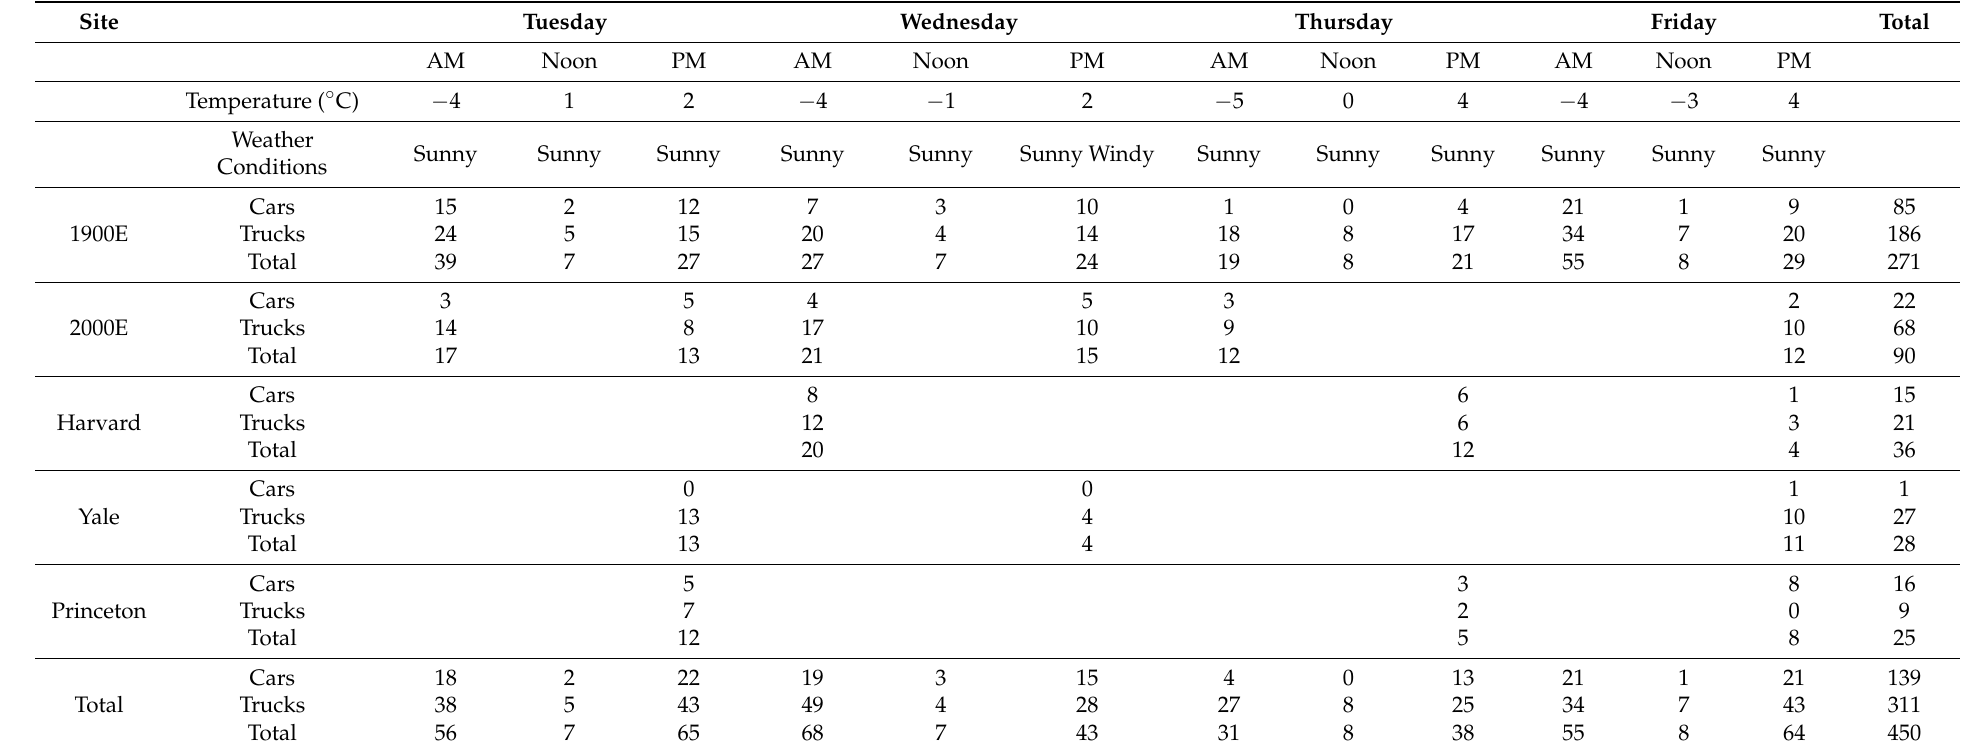
Table 4. Total vehicle counts during the post-intervention week: 18–21 February